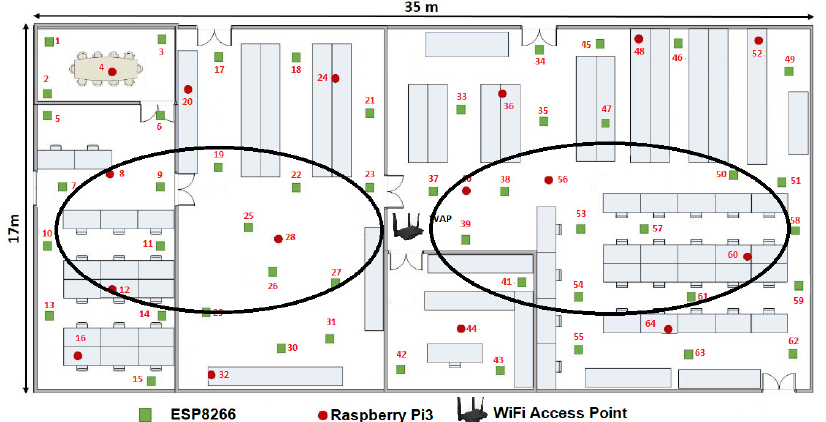
Figure 17. Hilbert fractal used for sorting all the reliable members of the proposed WSN applied in an experimental floor